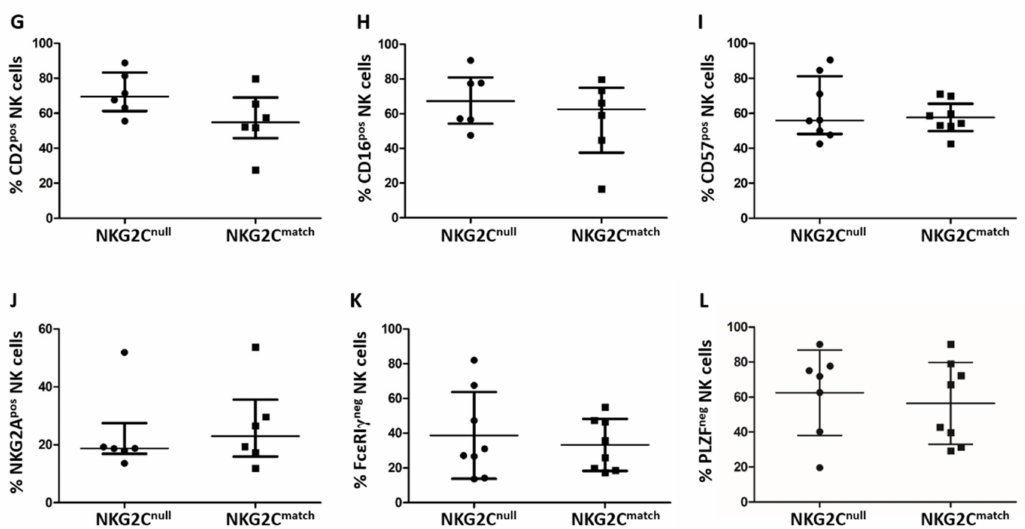
Figure 1. Phenotypic comparison of NK cells from NKG2C null and matched subjects. Cryopreserved PBMC were stained after overnight recovery with antibodies against human CD2, CD3, CD16, CD56, CD57, and NKG2A (extracellular) followed by Fc ε RI γ and PLZF (intracellular) fluorochrome-conjugated antibodies for flow cytometry. The gating strategy shown proceeds through selection of ( A ) the lymphocyte population, ( B ) exclusion of dead cells, and ( C ) selection of CD3 neg CD56 pos NK cells for further analysis of ( D – F ) CD2, CD16, CD57, NKG2A, Fc ε RI γ , and PLZF expression ( G ) Percent CD2 pos , ( H) CD16 pos , ( I ) CD57 pos , ( J ) NKG2A pos , ( K ) Fc ε RI γ neg , and ( L ) PLZF neg NK cells were compared between the NKG2C null and NKG2C match groups. Data were displayed as mean values with SD and differences compared by the Student’s t test when data are normally distributed ( K , L ). Data are displayed as median with IQR and differences are compared by the Mann-Whitney test when they were not normally distributed ( G – J ). Statistically significant differences are shown on graphs above lines spanning comparison